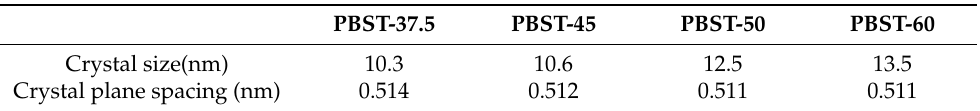
Table 2. Crystal size and crystal plane spacing of PBST copolymers with different BT contents when the diffraction peak was at 17.3 ◦